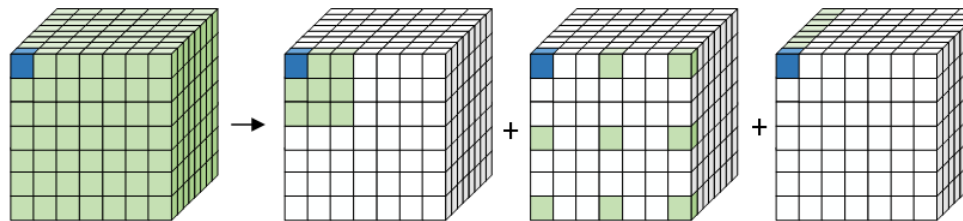
Figure 3. The standard large kernel convolution can be separated into three operations to decrease the number of computations, e.g., a depthwise convolution (DW-C), a depthwise division convolution (DW-D-C), and a pointwise convolution (PW-C). In the figure, blue is the center point, and green represents the range of